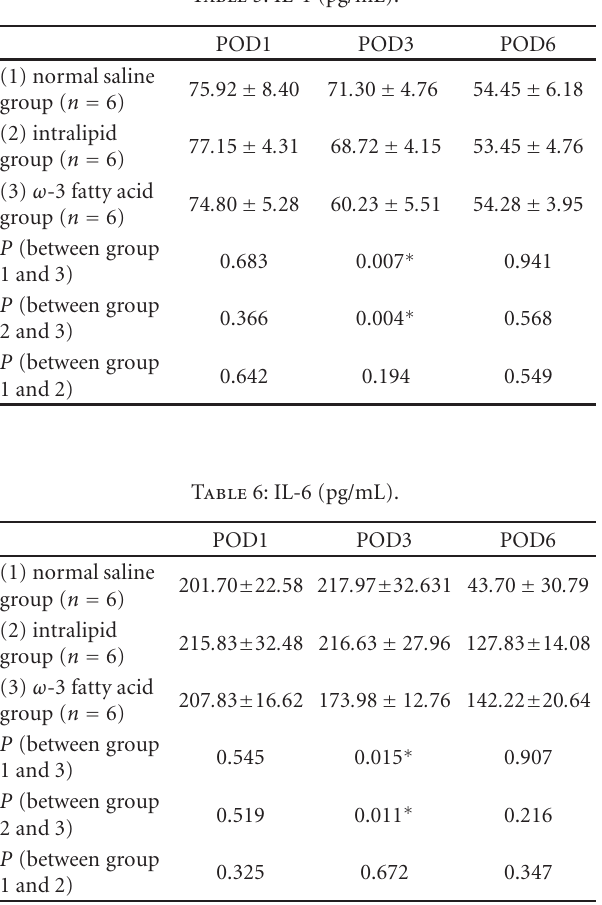
Table 7: TNF- α (pg/mL).